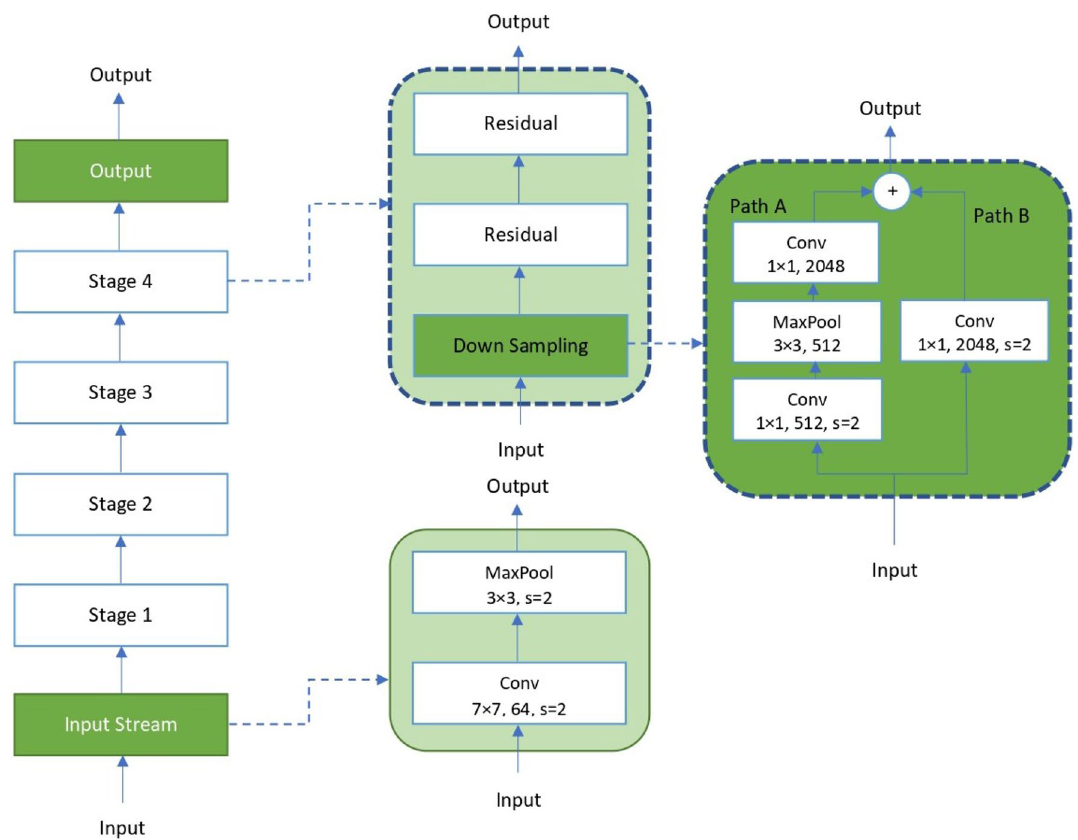
Figure 4. The ResNet Architecture, the convolution kernel size, output channel size and stride size (default is 1) are illustrated, similar for pooling layers.This figure was created with Microsoft